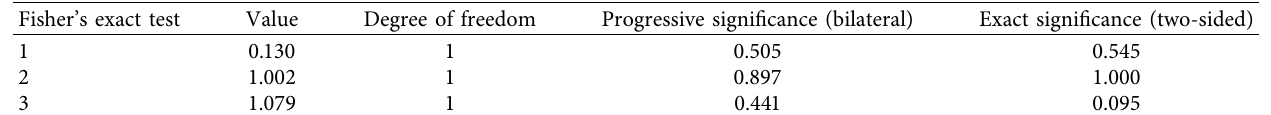
Table 8: Chi-square analysis of the foul type and